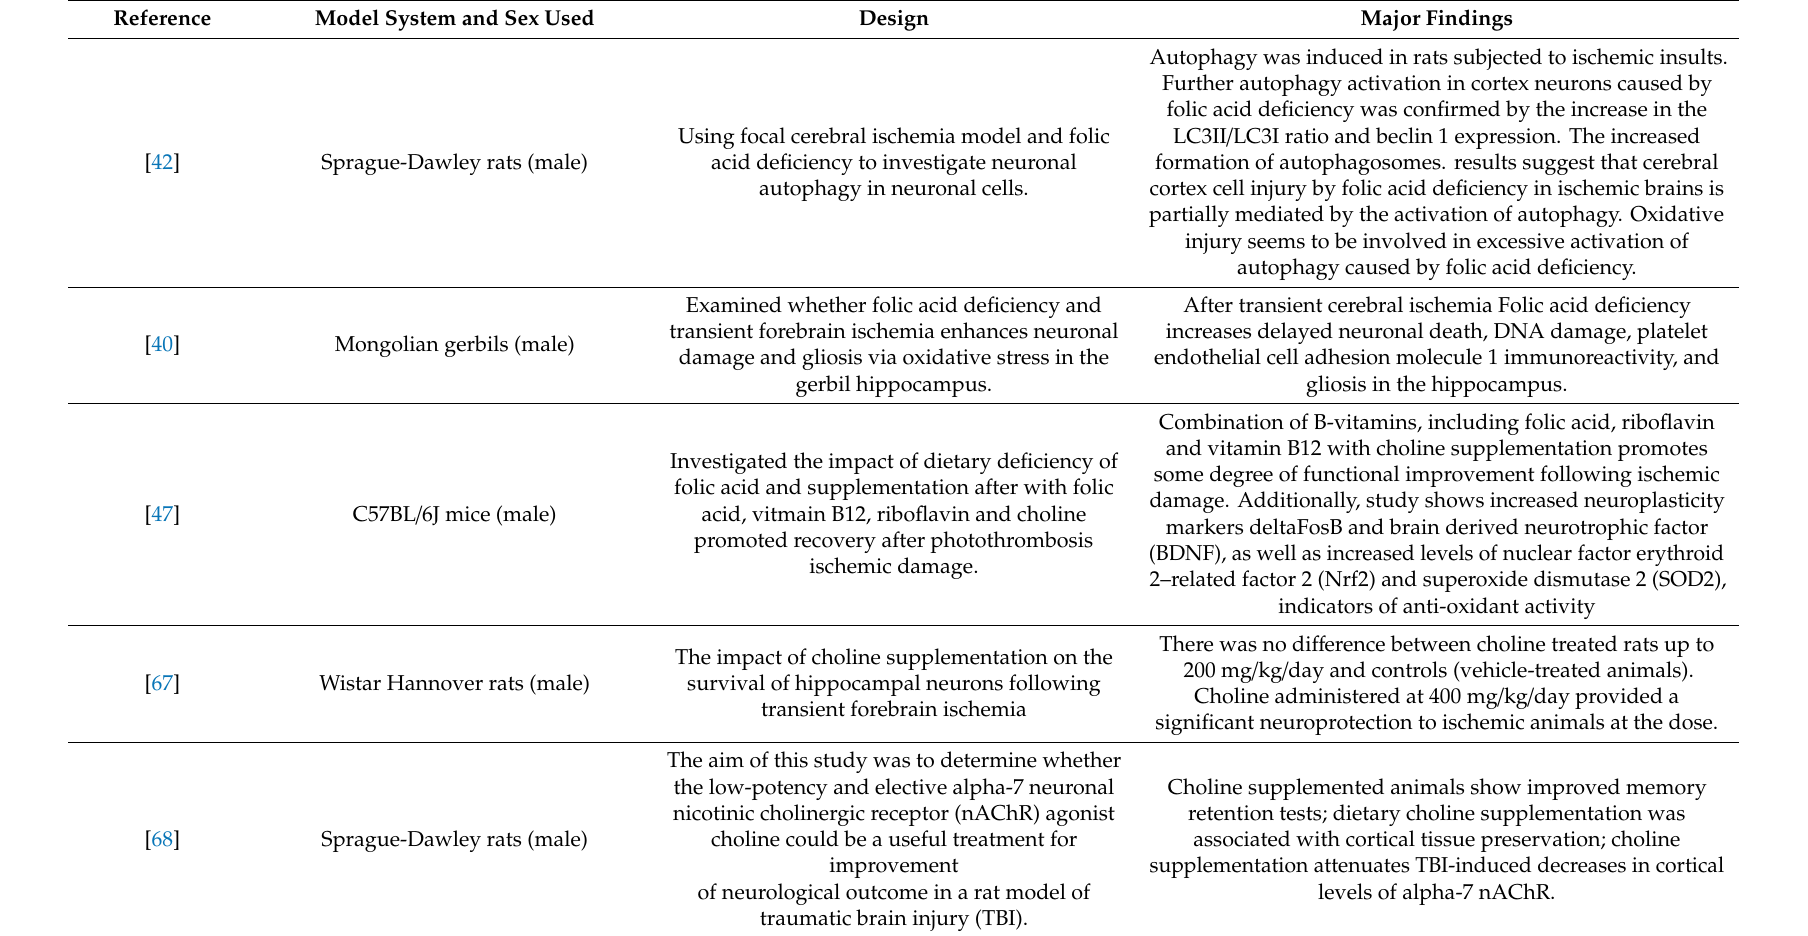
Table 1. Summary of main findings of model system